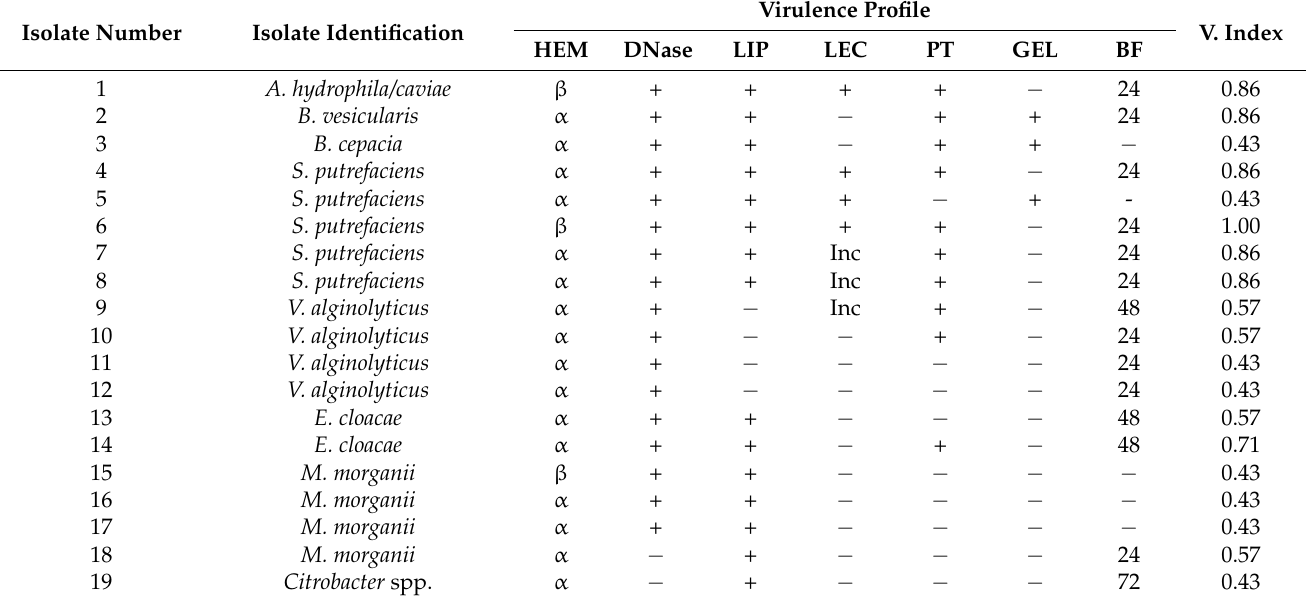
Table 3. Selected isolates’ virulence